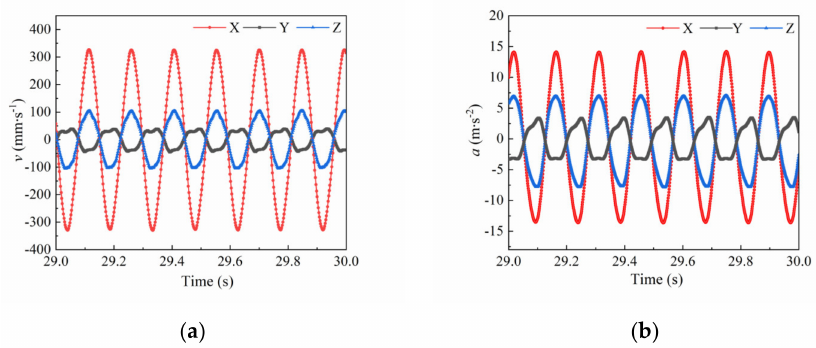
Figure 6. Time-domain response curves of velocity and acceleration. ( a ) Time-domain curve of velocity in different directions. ( b ) Time-domain curve of acceleration in different directions.